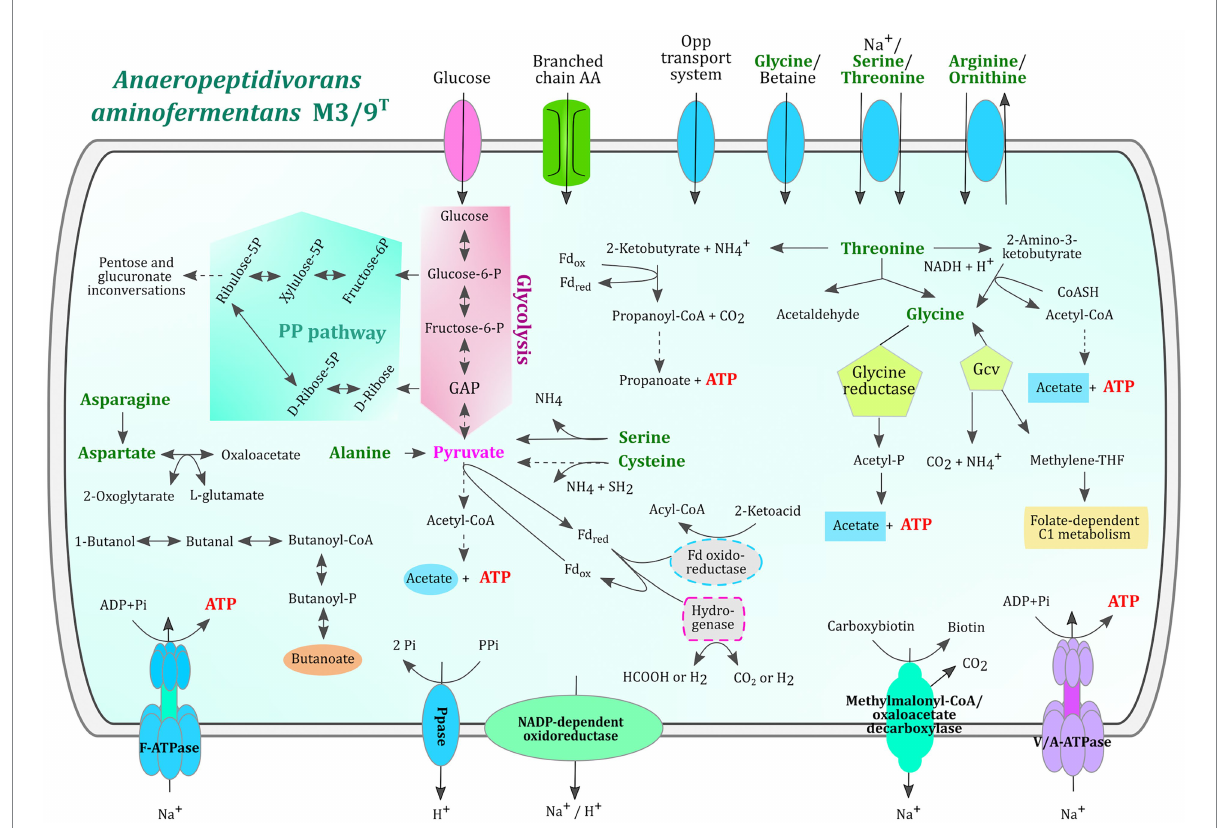
FIGURE 3 Metabolic reconstruction of relevant metabolic features and amino acid utilization in A. aminofermentans M3/9 T . The metabolic reconstruction was performed with KEGG pathway maps represented in GenDB. The glycolysis and the pentose phosphate pathways are highlighted in pink and green, respectively. Amino acids proposed to be utilized by A. aminofermentans M3/9 T are written in green and corresponding transport systems are displayed in blue ovals. Metabolic pathways shown in the figure are completely encoded in the